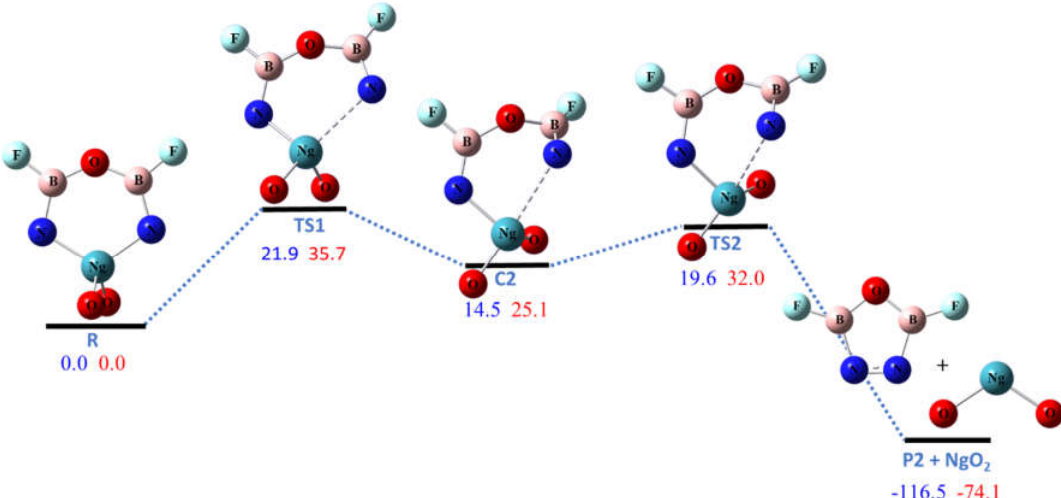
Figure 3. The calculated potential energy (in kcal/mol) profile for the dissociation pathway R2 at